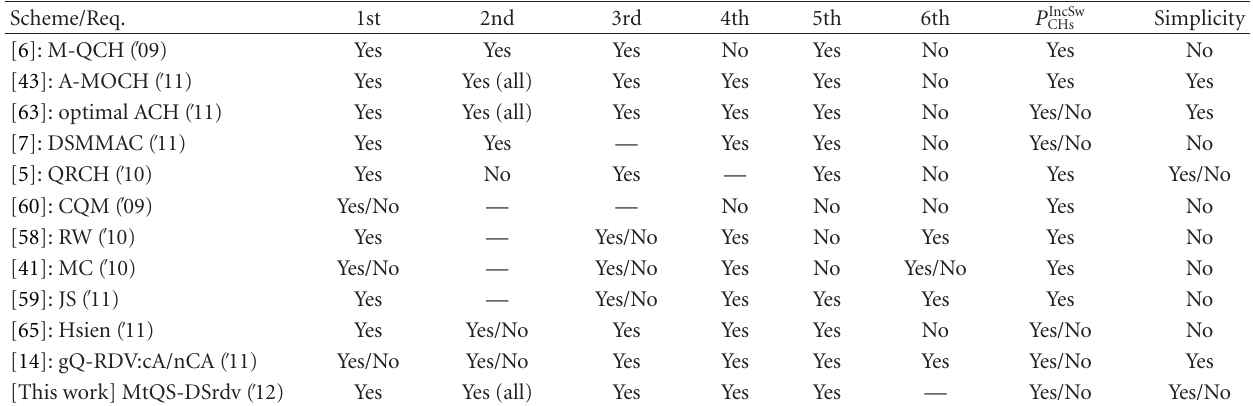
Table 2: Comparison according to CH requirements: Yes, Yes/No, No, — (Not elaborated), Yes (all) means RDV on all channels; CHC requirements: (1st) RDV guarantee on at least one channel; (2nd) RDV guarantee on multiple channels; (3rd) TTR small and bounded; (4th) No synchronization/coordination; (5th) No global or neighborhood information; (6th) Symmetric and asymmetric channels. Scheme/Req.